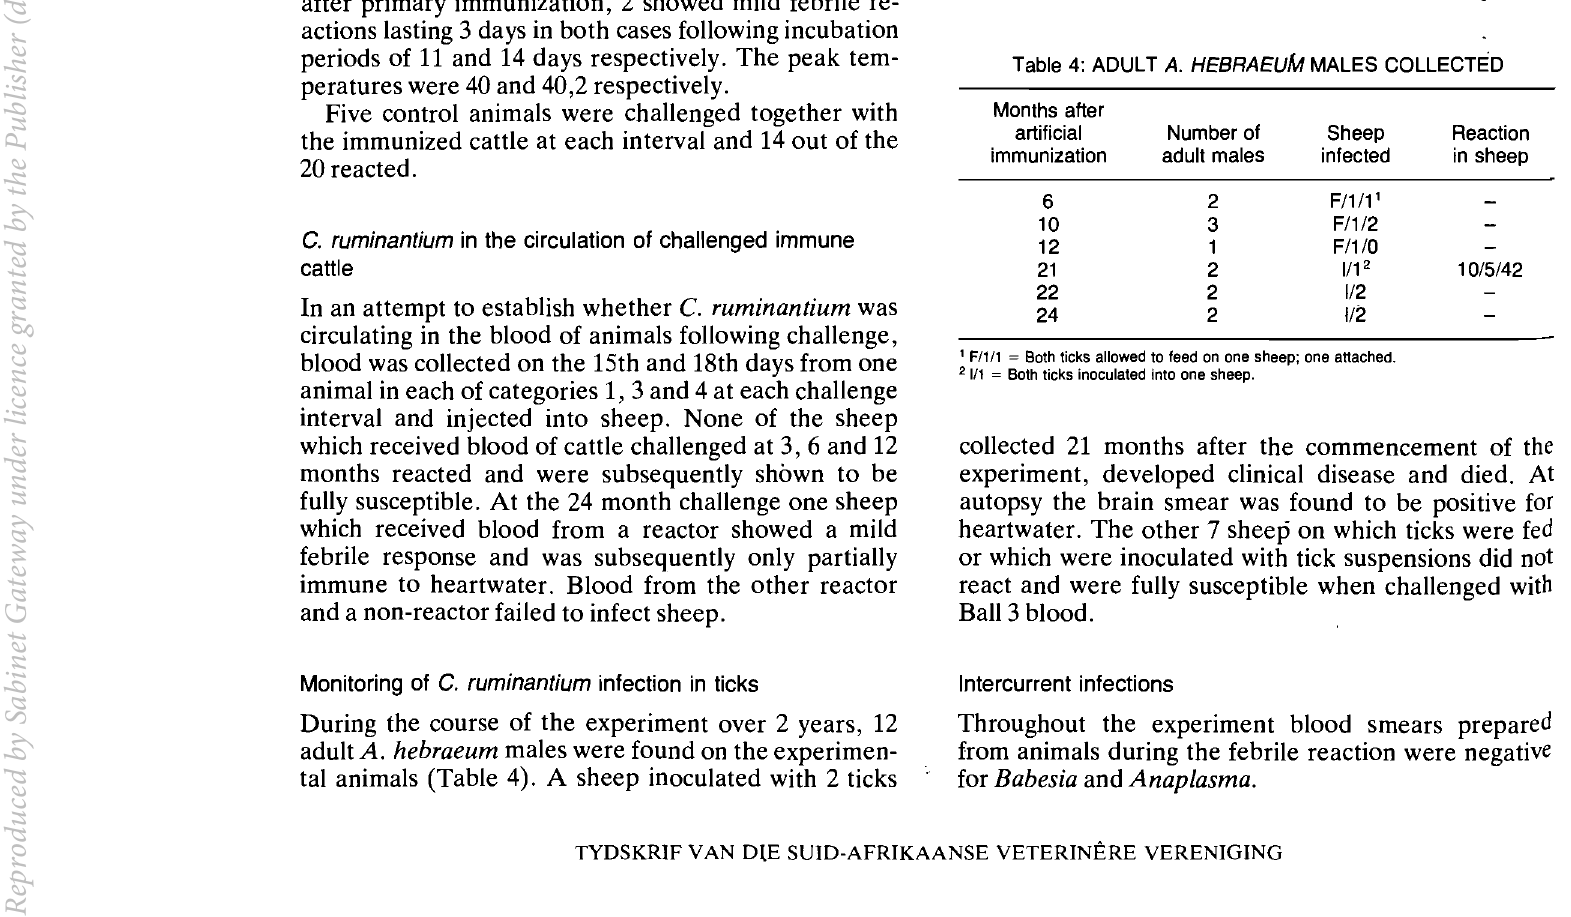
Table 4: ADULT A. HEBRAEUM MALES COLLECTED Months after artificial Number of Sheep